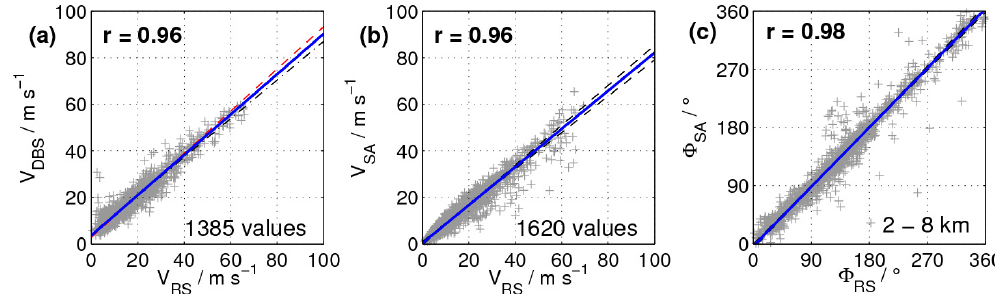
Fig. 4. Scatter plots of wind speed obtained from Doppler experiment (a) , spaced antenna wind speed (b) and direction (c) for the ALWIN VHF radar and radiosondes for the altitude range between 2 and 8km. The crosses mark the hourly median values, the lines are correlations concerning that both variables have errors.